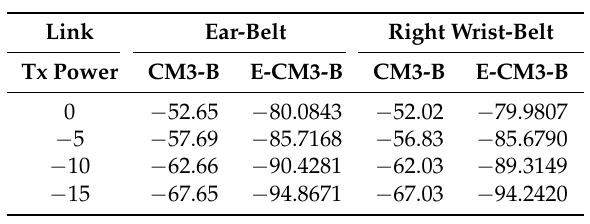
Figure 13. Average packet delivery ratio at varying transmission power for one and three BANs (having three nodes per BAN). Table 9. Average received power for ear and belt (with distance equal to 0.26 m) and right wrist and belt (0.334